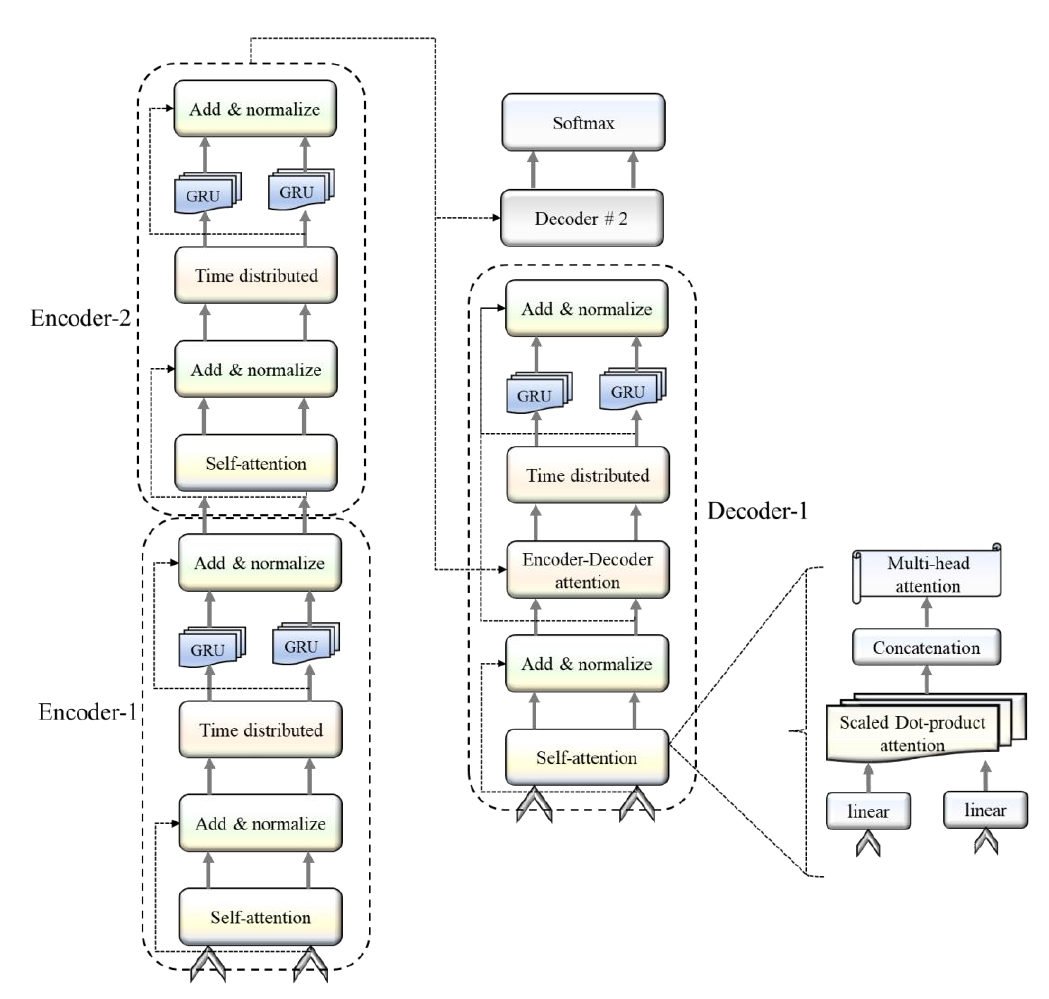
Figure 6; the model comprises stacked encoders and decoders with multihead attention and time-scattered layers.